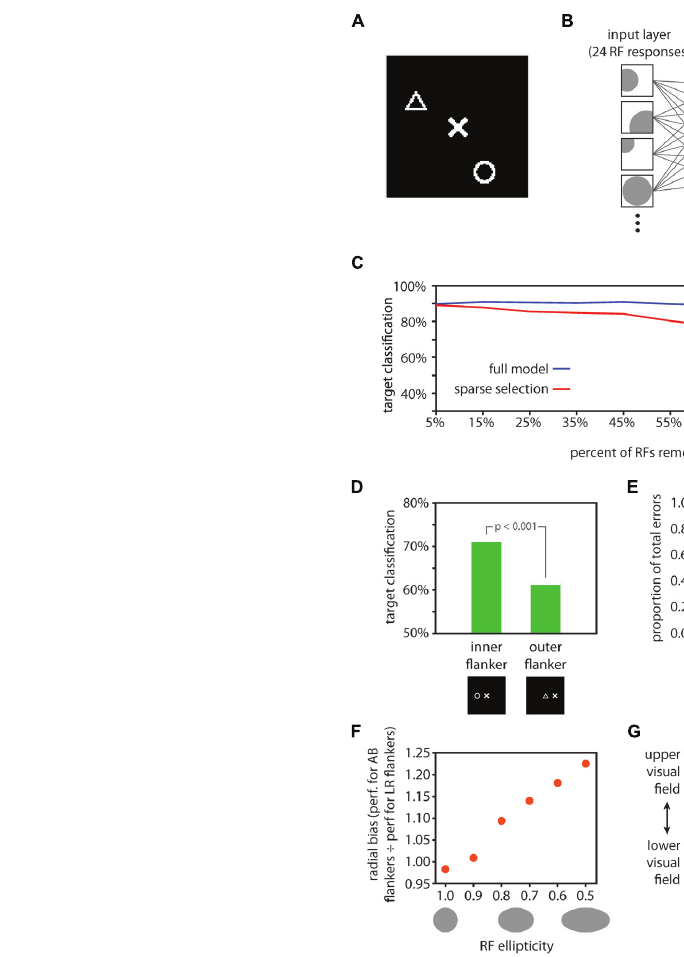
FIGURE 3 | Computational model results. (A) Example display for model training and testing. One symbol (the target item) was positioned in the center of the image, and two other randomly selected symbols (flankers) were positioned in random locations elsewhere in the image. (B) Schematic depiction of the neural network decoding model.Twenty-four receptive fields were tiled in random locations over the image. RFs had random tuning functions, but an equal number of RFs were optimally tuned to each of the three symbols (8 RFs optimally tuned to each of circles, triangles, and Xs). The model contained a ten unit hidden layer and a three unit output layer. Each node in the hidden layer was connected with each of the 24 RFs, and with each of the three nodes in the output layer.The three output layer nodes corresponded to the three symbols, and stimulus decoding was determined by taking the maximally responsive node in the output layer in a winner-take-all fashion. (C) Comparison of performance for the full model vs. the sparse selection model.While the full model classified the target symbol with high accuracy (90.4% correct) despite the presence of flankers (blue data), classification performance of the sparse selection model decreased monotonically as more connections were removed (red data).Thus, although fine-scaled information can be decoded from a population of neurons with large receptive fields, robust decoding of crowded stimuli relies on a full sampling of the information present in the neural population. (D) RF scaling with eccentricity yielded the inner-outer asymmetry characteristic of visual crowding.We tested the model performance using images with one flanker positioned either on the foveal side of the target symbol (here shown to the left of the target symbol) or on the eccentric side of the target symbol. Classification was significantly worse when an outer flanker was present vs. an inner flanker ( p < 0.001), mirroring effects found in human performance (Bouma, 1973; Petrov etal., 2007). (E) Using the same test images as those